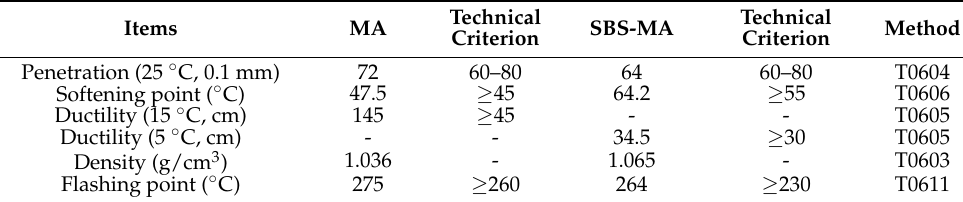
Table 2. Properties of matrix asphalt (MA) and SBS-modified asphalt (SBS-MA).